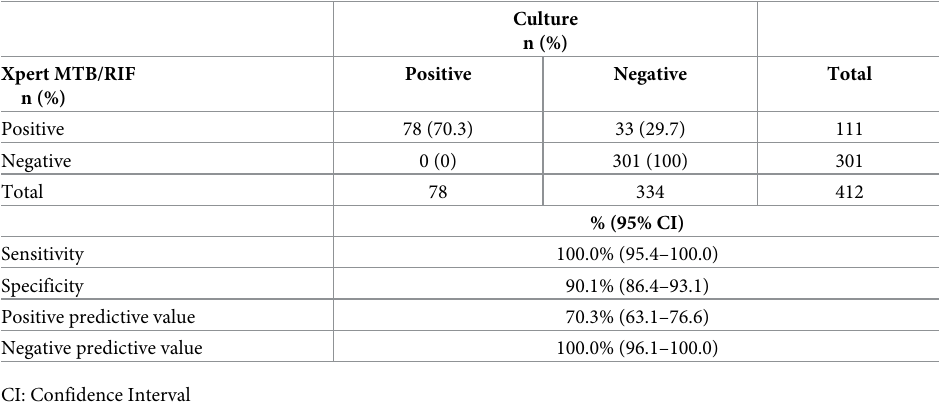
Table 2. Sensitivity, specificity, positive and negative predictive values of Xpert MTB/RIF, using culture as gold